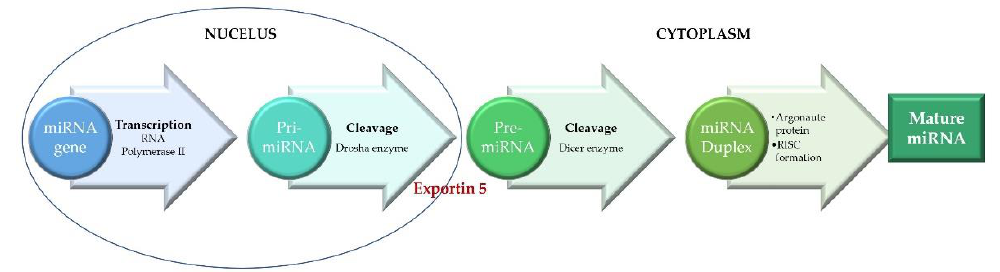
Figure 1. miRNA biogenesis.